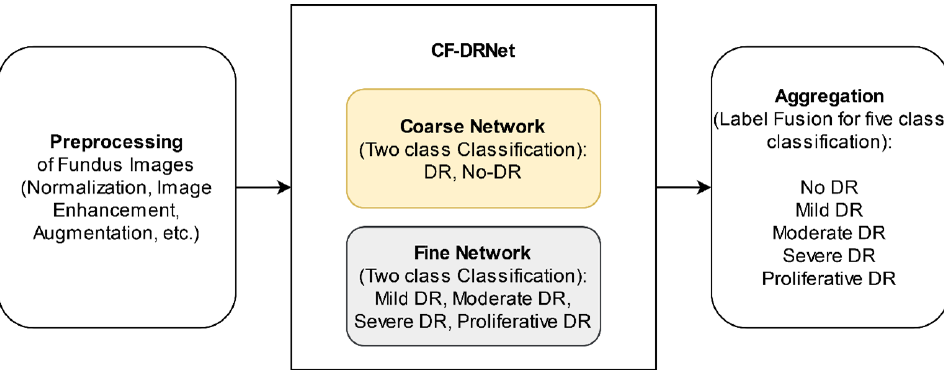
Figure 4. Coarse–Fine Diabetic Retinopathy Network